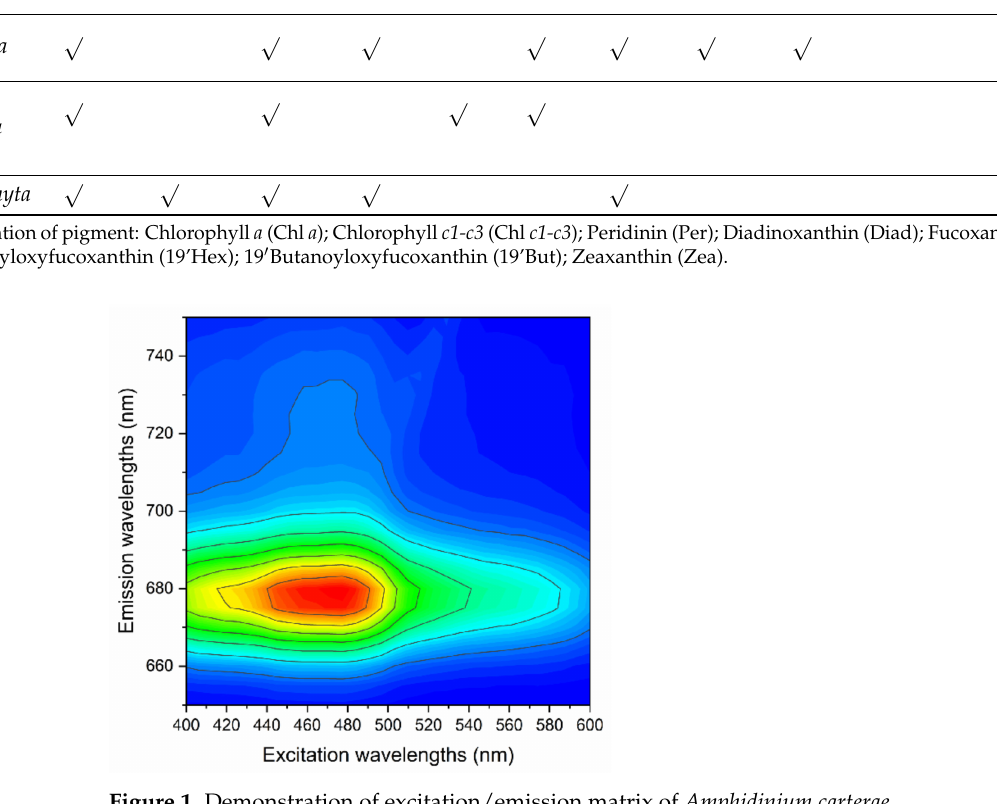
Figure 1. Demonstration of excitation/emission matrix of Amphidinium carterae